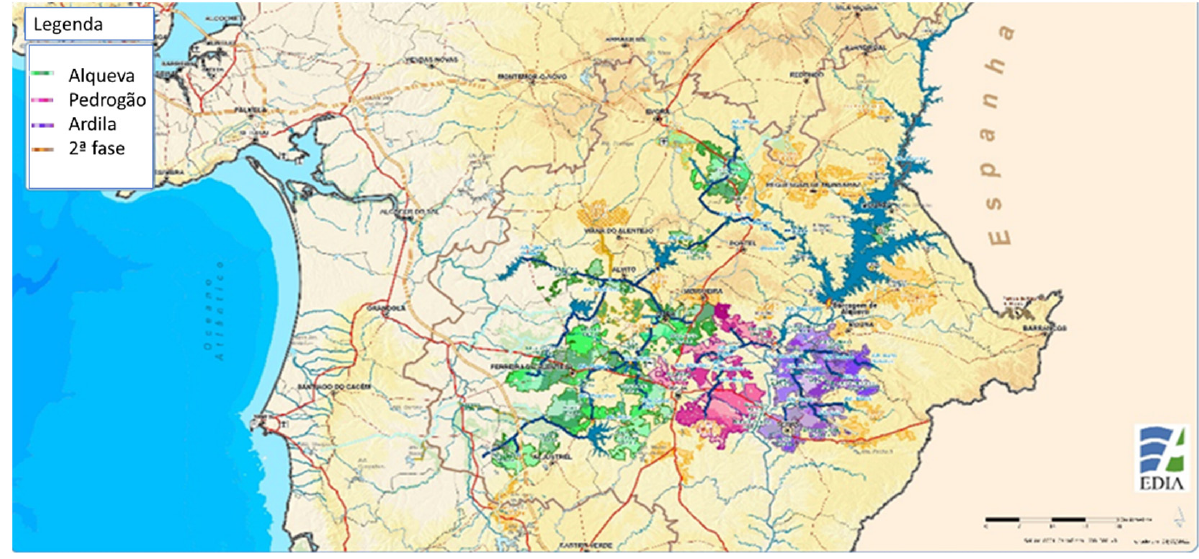
Figure 1. Map of Alqueva Dam irrigation area. Table 1. Main cultures practice in the Alqueva Dam irrigation area. In Table 1, ha = 10,000 m 2 . * Intensive olive groves.